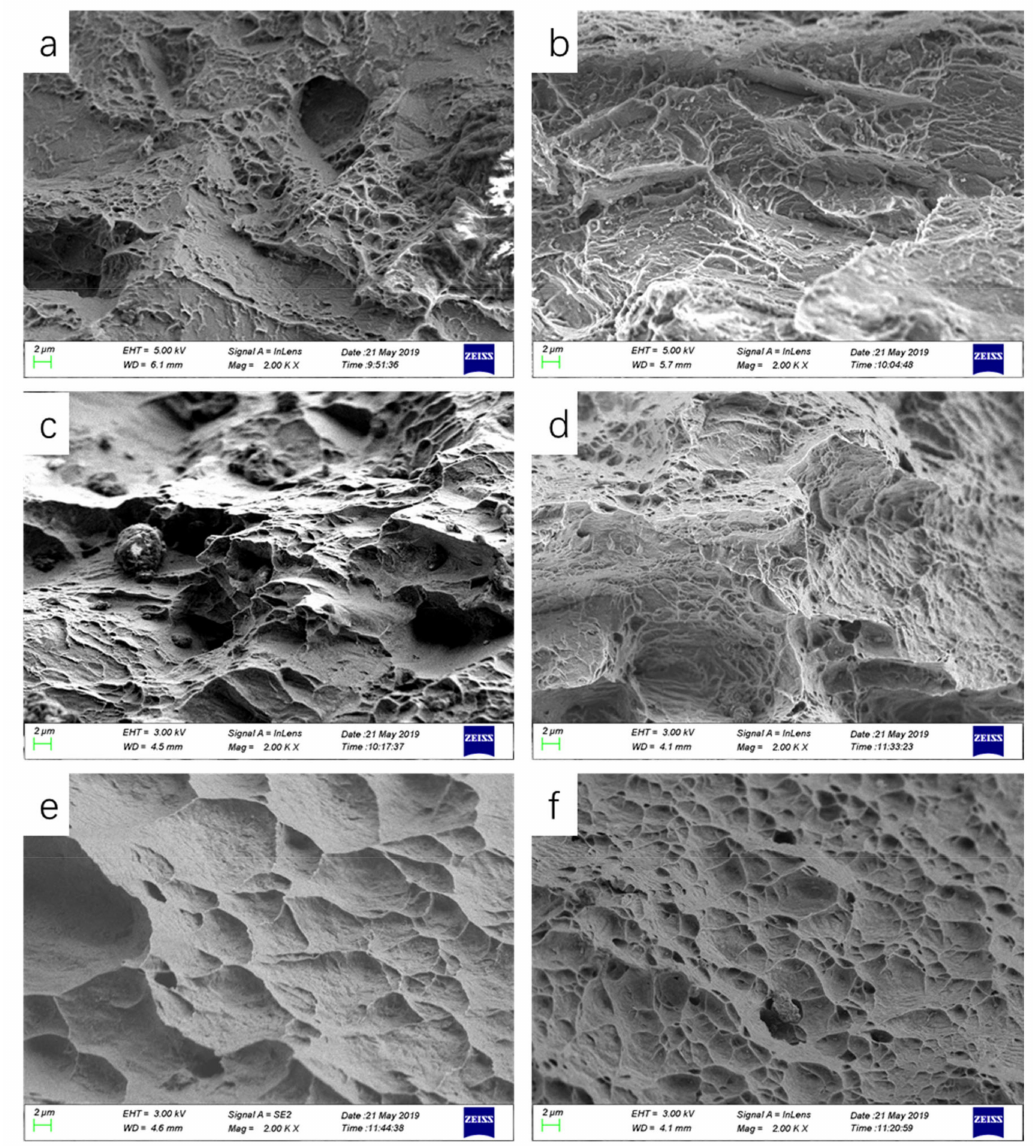
Figure 10. Morphologies of fracture surface for the samples stretched at ( a ) 0.001 s − 1 and 213 K, ( b ) 1300 s − 1 and 213 K, ( c ) 0.001 s − 1 and 293 K, ( d ) 1300 s − 1 and 293 K, ( e ) 0.001 s − 1 and 423 K, and ( f ) 1300 s − 1 and 423